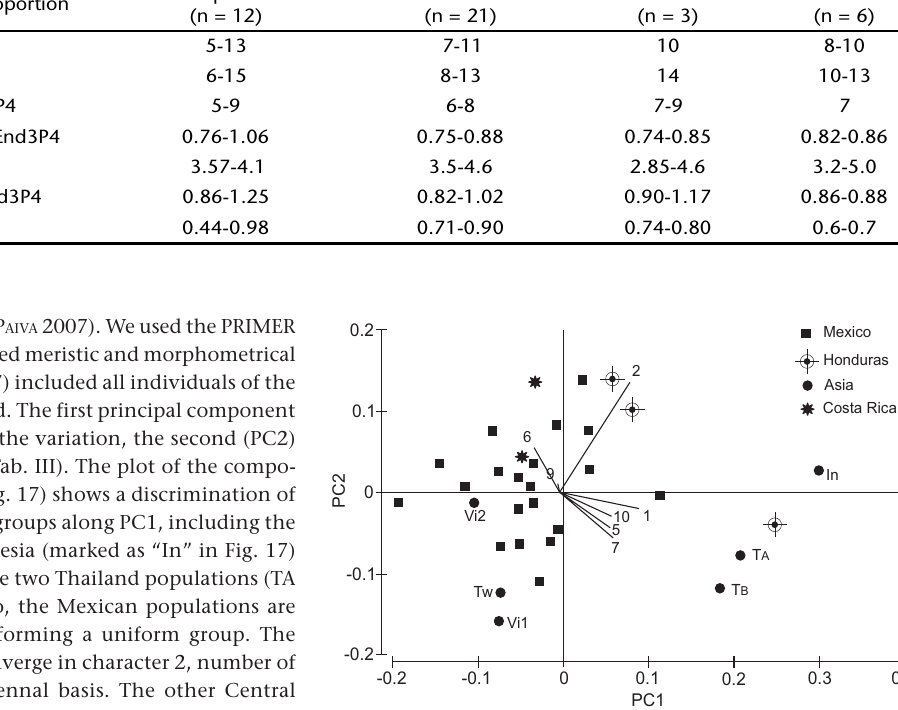
Table II. Summarized data of the variation of appendage ornamentation and other morphological characters among three different groups of populations of Mesocyclops thermocylopoides . (P4) Fourth swimming leg, (End3P4) third endopodal segment of fourth swimming leg. Number of spines in rows/proportion